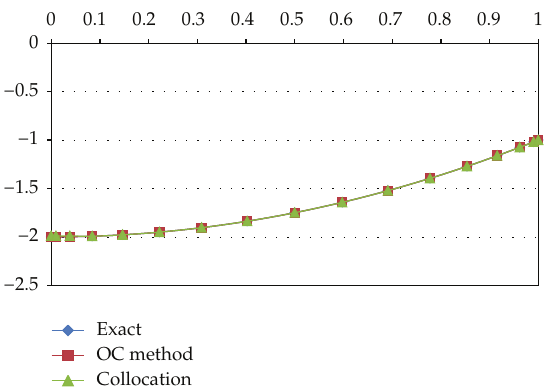
Figure 3: Observed results for Example 4.3 (cid:2) N (cid:7) 16 (cid:3)